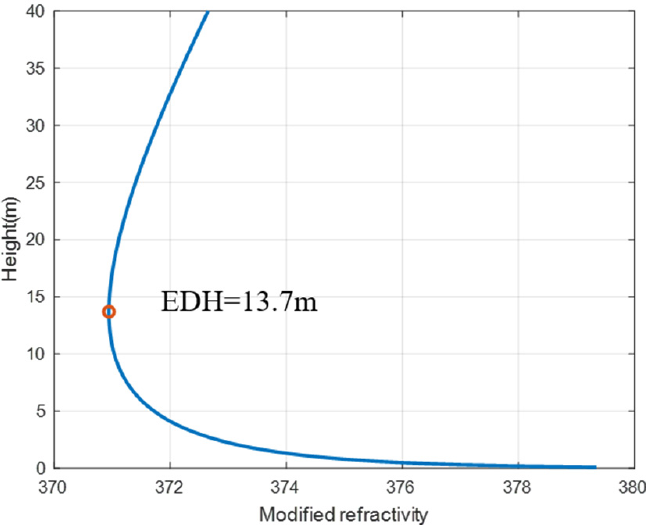
Figure 5. Modi fi ed refractivity pro fi le estimated using the evaporation duct model. Figure 5. Modified refractivity profile estimated using the evaporation duct